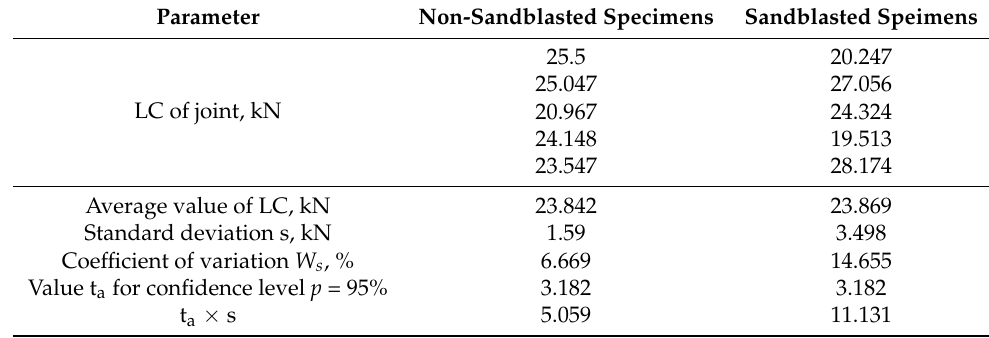
Figure 4. View of the fracture mode of ( a ) sandblasted and ( b ) non-sandblasted butt welds. Table 2. Statistical analysis of the static tests results.